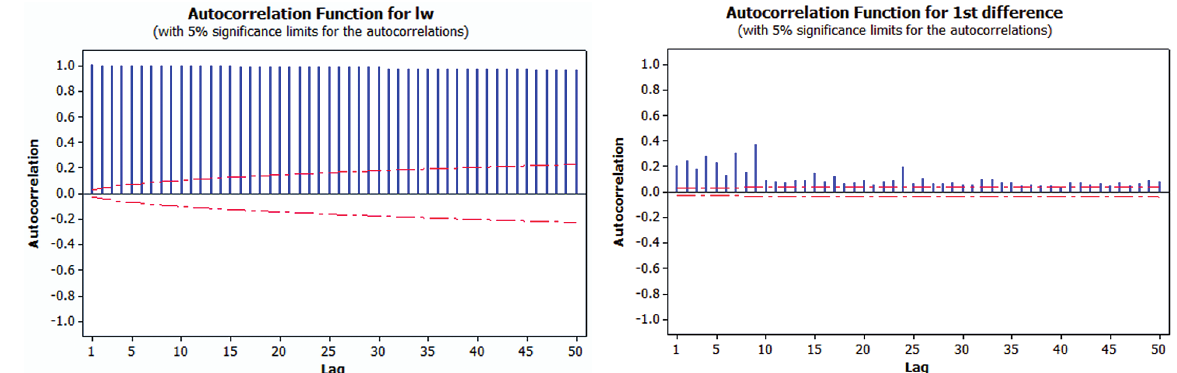
Fig. 2. Correlograms for the eigenvalues of matrix W for the 1990 Syracuse, NY, census block surface partitioning Left (a): the raw eigenvalues. Right (b): 1st-differenced